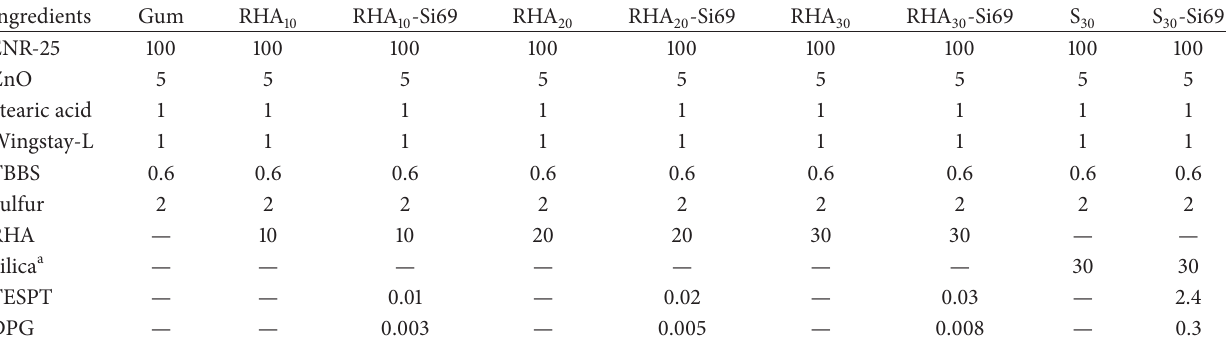
Table 1: Compounding